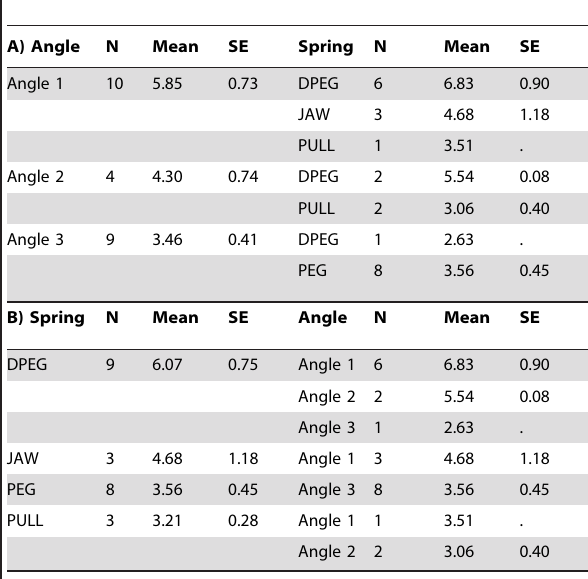
Table 5. Mean values and standard errors of clamping force (N) among mouse trap